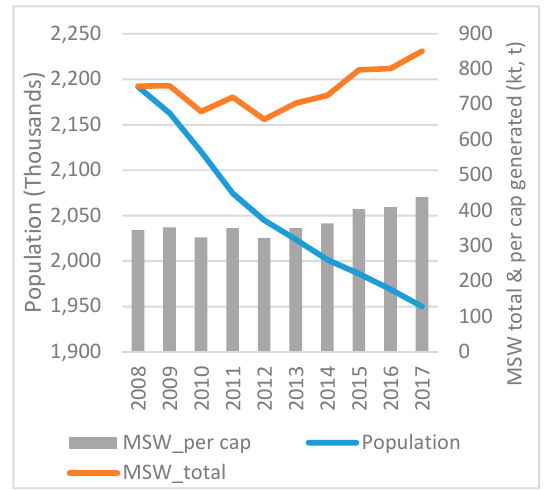
Figure 27. Population and MSW production in Latvia 2008–2017 (EUROSTAT 2019a, 2019c).